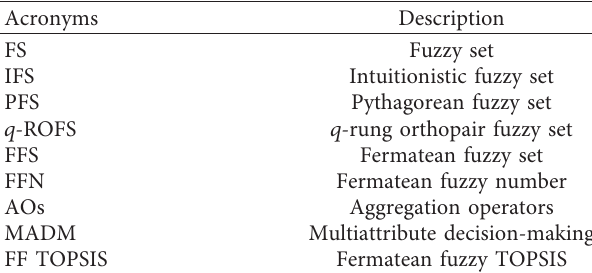
Table 1: List of